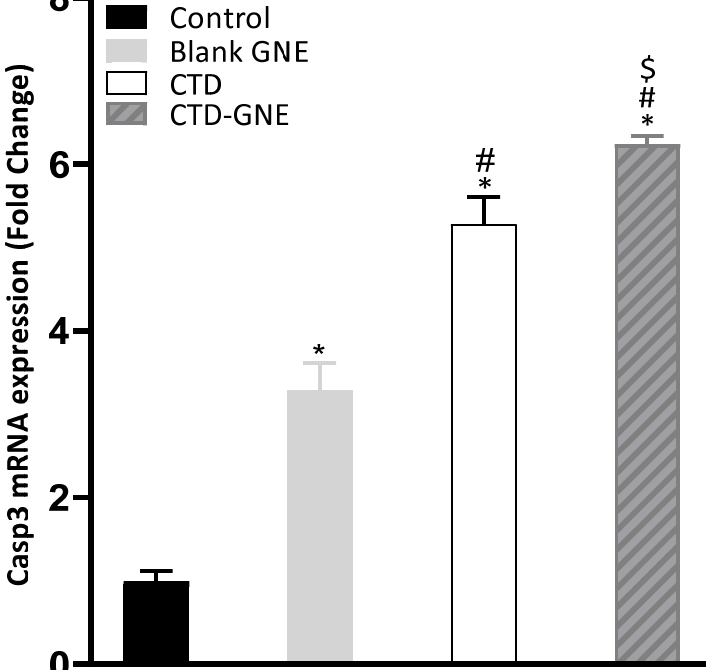
Figure 7. RT-qPCR analysis of the casp3 mRNA expression levels. Expression levels were normalized to the reference gene β -actin using the comparative Ct method (2 − ∆∆ Ct ). All data are expressed as the mean ± SE of three independent experiments. * p < 0.05 is considered significantly different from the control, # p < 0.05 is considered significantly different from blank GNE, and $ p < 0.05 is considered significantly different from CTD.